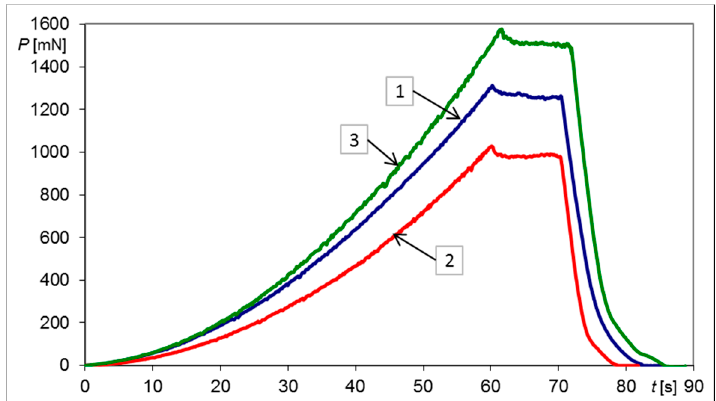
Figure 4. Indentation test histories P – t performed to reach a penetration depth h* = 4 μ m with a Vickers probe for a circular sample made of X20Cr13 steel, where: (1) simply supported plate, no bending (reference)—blue line, (2) after second loading—red line (plate deflection ∆ U 3 = 334.2 µ m), (3) after second unloading—green line (permanent deflection ∆ U 4 = 136.4 µ m).